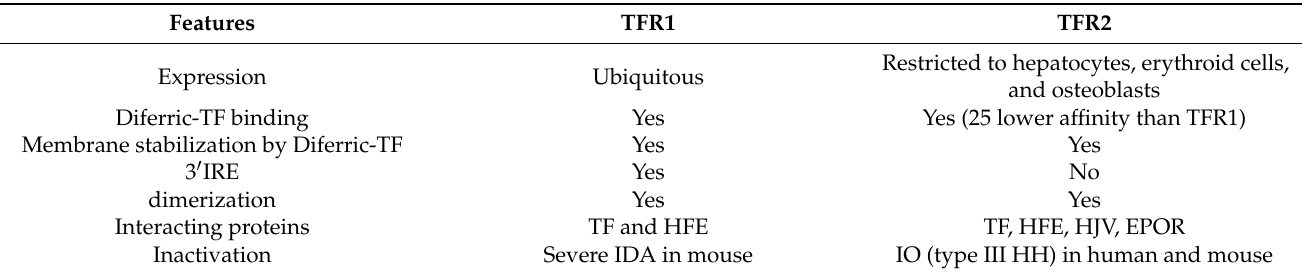
Table 1. Comparison between TFR1 and